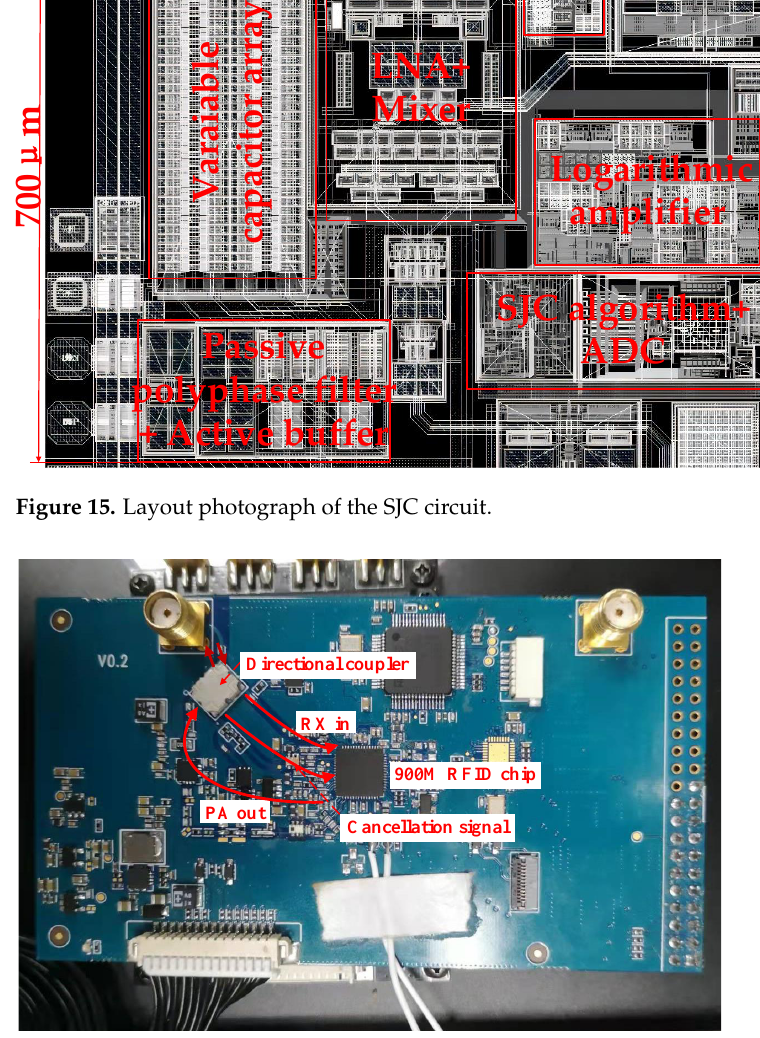
Figure 16. Hardware photo of the 900 MHz RFID test